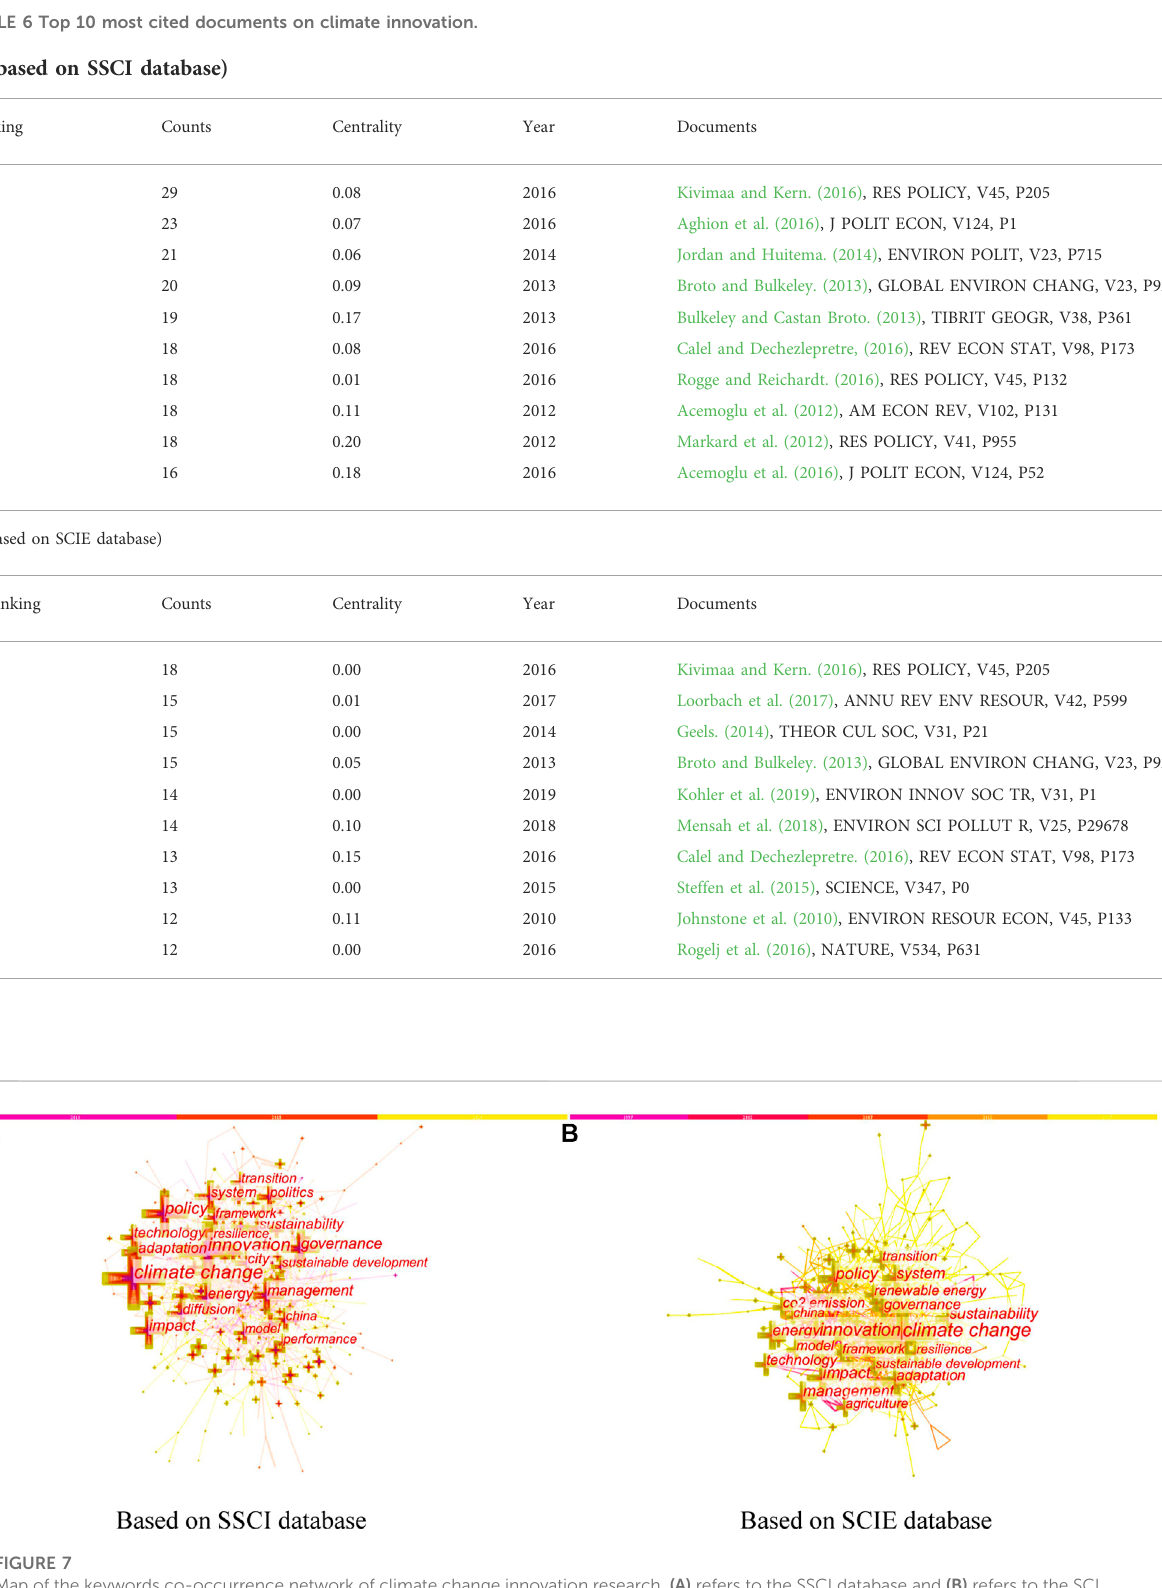
TABLE 6 Top 10 most cited documents on climate innovation.